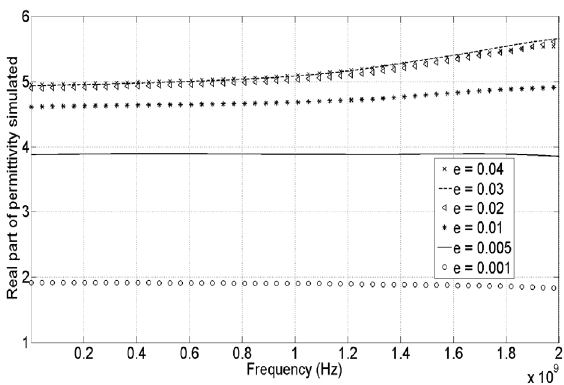
different thicknesses e (m). Effect of an air gap between the probe and the sample